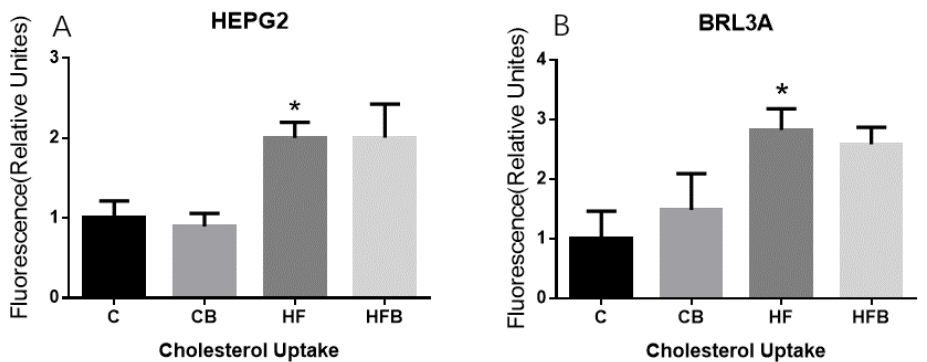
Figure 12. Effects of betaine and high-fat medium on cholesterol uptake of hepatic cells in vitro ( n = 6). ( A ) The level of cholesterol uptake in HepG2: BET, p = 0.647, FAT, p < 0.001, interaction, p = 0.615. ( B ) The level of cholesterol uptake in BRL3A: BET, p = 0.546, FAT, p < 0.001, interaction, p = 0.090. C—normal medium, CB—normal medium supplemented with 10 mmol / L